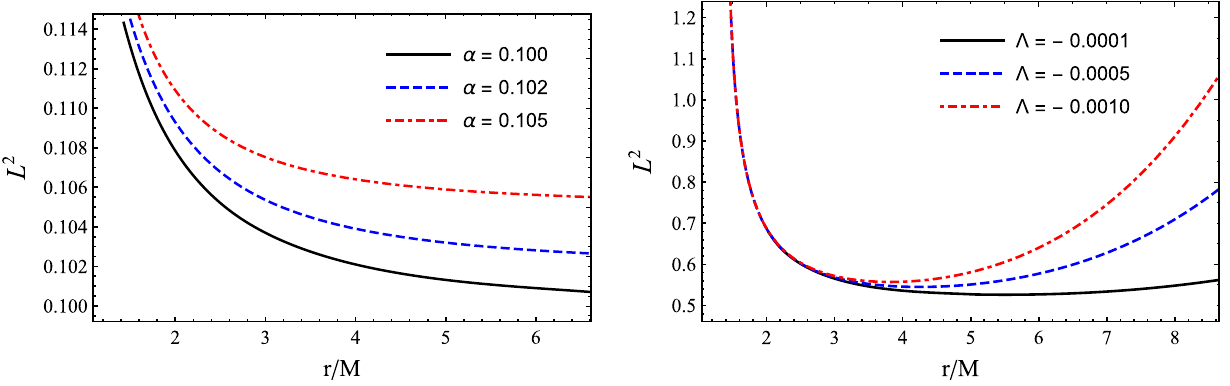
Fig. 2 The radial dependence of the specific angular momentum for test particles around the GB (2+1)-dimensional BTZ black hole. Left panel: for the different values of parameter α in the case of a vanishing